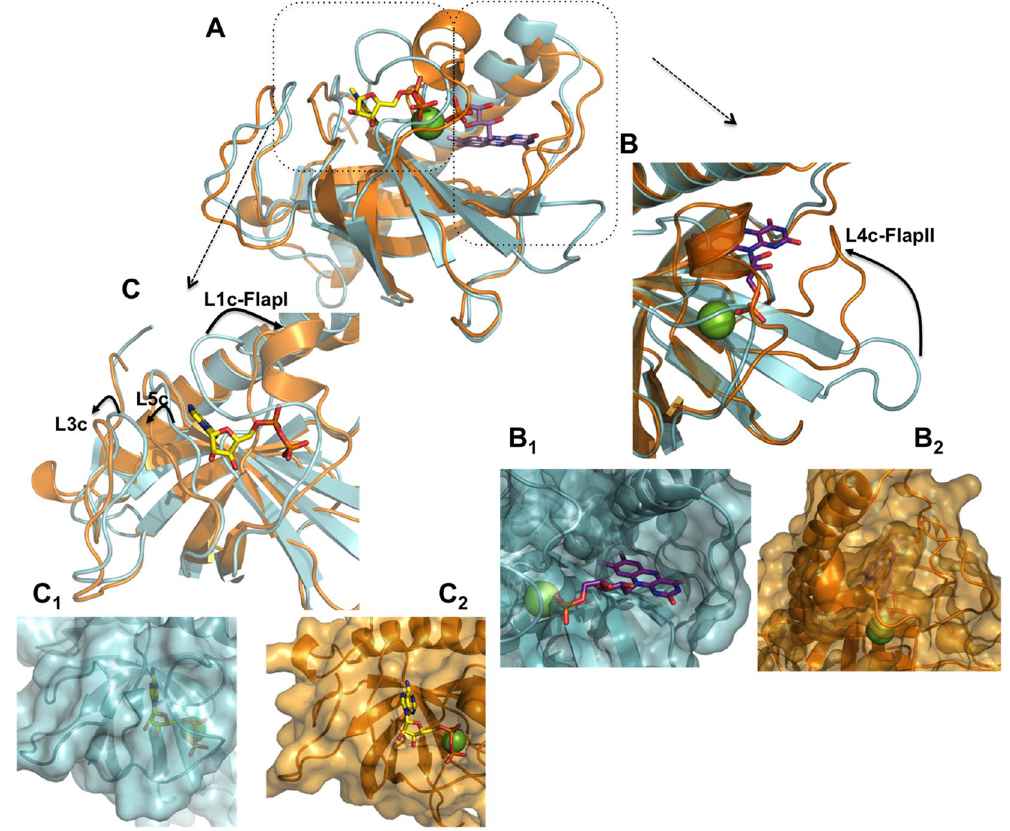
Figure 6. Structure of the RFK module of Ca FADS. Crystallographic structures of the RFK module when free (blue, PDB 2x 0 k) and in the ternary complex with the FMN and ADP:Mg 2 + products (orange, PDB 5a89). ( A ) Superposition of both structures. ( B ) Detail of the flavin nucleotide-binding cavity. B 1 shows the open conformation of the cavity in the free enzyme, where the phosphate of FMN and the Mg 2 + cation will find their binding site blocked by residues of L1c. B 2 shows the enclosure of the flavin ring by L4c in the ternary complex. ( C ) Detail of the adenine nucleotide-binding cavity. C 1 shows the closed conformation of the ANP-binding site in the free enzyme, where the phosphates of ANP and the Mg 2 + cation will find their binding site blocked by residues of L1c. C 2 shows the open conformation of this cavity with ADP:Mg 2 + bound in the ternary complex. In all panels, the ligands correspond to those in the 5a89 structure. ADP and FMN ligands are shown as sticks and are CPK colored with carbons in yellow and purple respectively, and the Mg 2 + cation is shown as a green